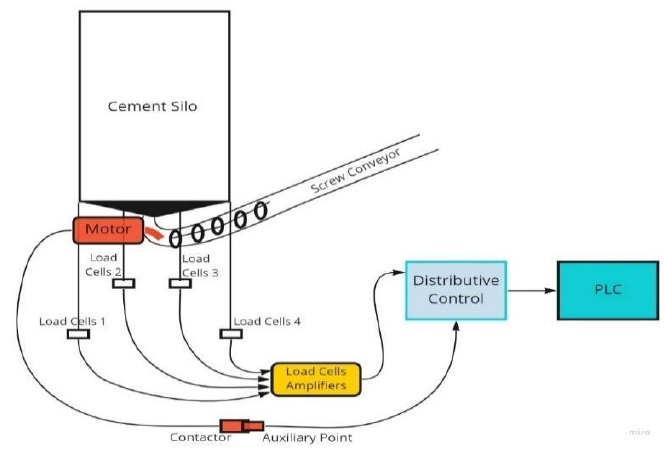
Figure 9. Cement Weighing and Conveying Operation.